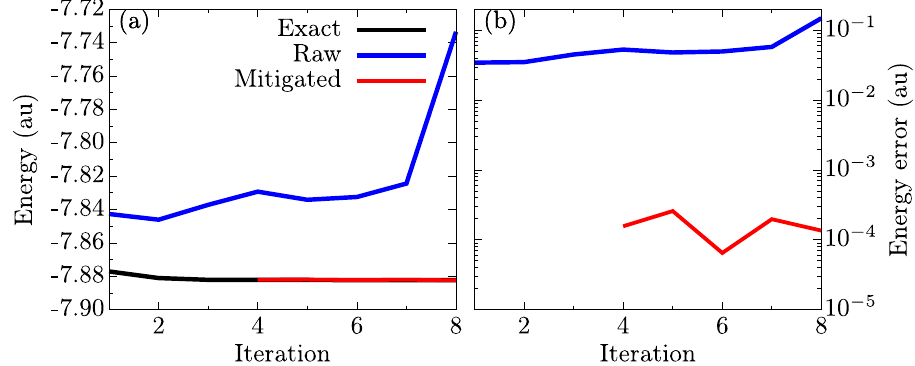
Fig. 6 Simulation of the LiH molecule (10 qubits) on the IBMQ-Bogota quantum device (5 qubits) with (red) and without (blue) error mitigation and their comparison to the exact solution (black). We do not show mitigated results for the fi rst three iterations as Clifford data regression (CDR) gives perfect correction for these circuits since they contain at most one non-Clifford gate. The error rate of the CNOT gate is between 1.06 × 10 − 2 ~ 2.02 × 10 − 2 and 1.62 × 10 − 2 on average at